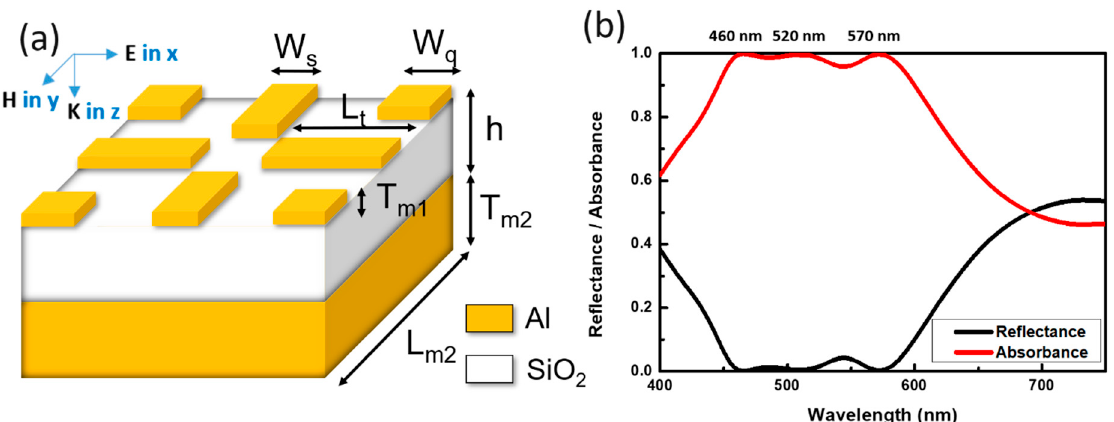
Figure 1. ( a ) Schematic illustration of the proposed dual-resonator based light absorber with defined structural parameters. ( b ) The calculated reflectance and absorbance spectra of the designed light absorber.